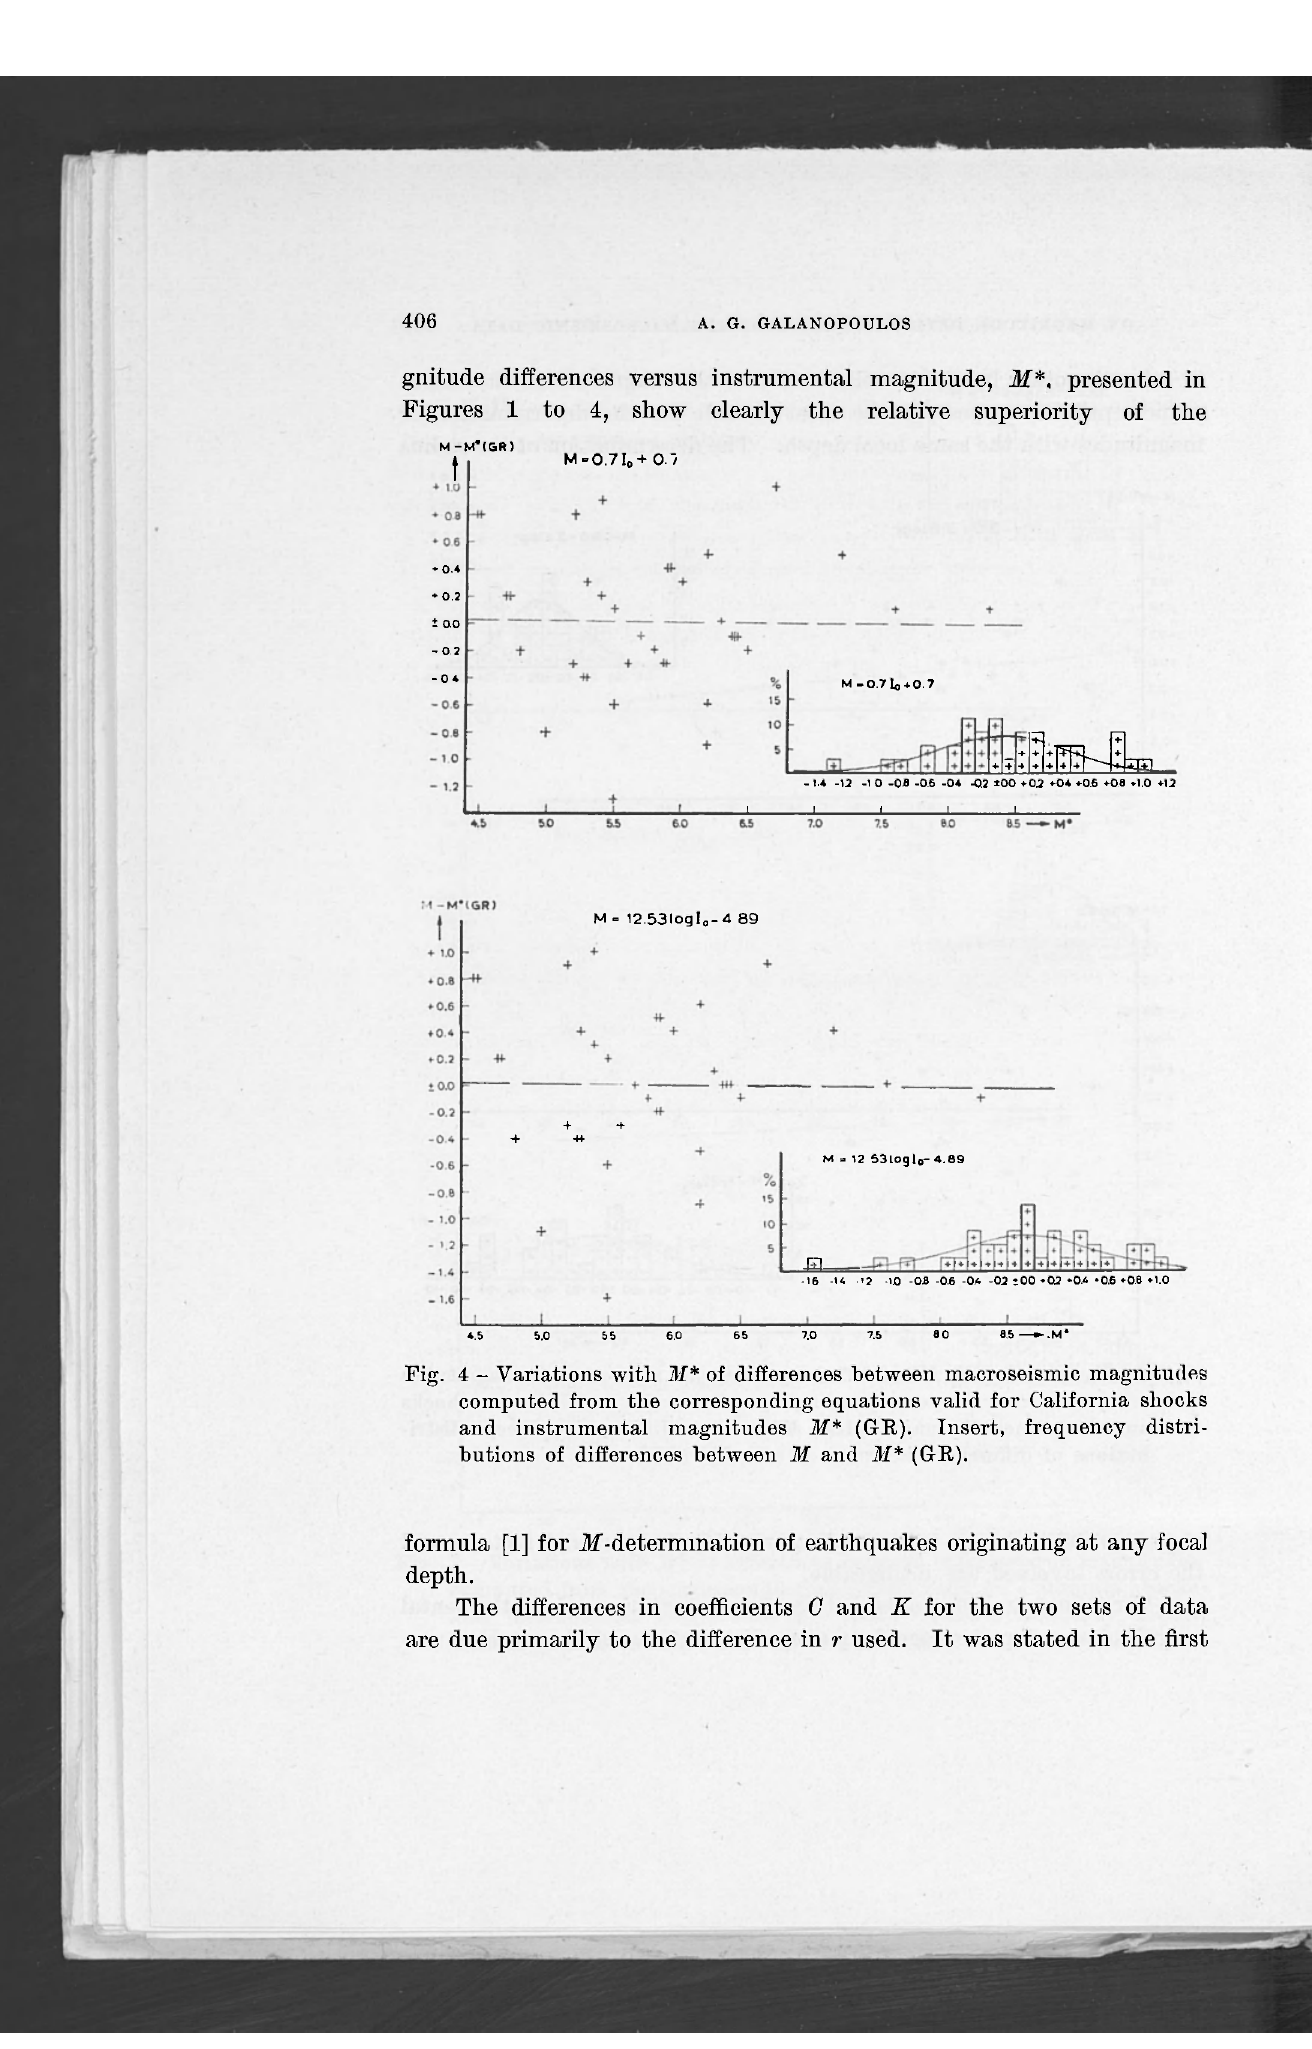
Fig. 4 - Variations with M* of differences between maoroseismic magnitudes computed from the corresponding equations valid for California shocks and instrumentai magnitudes M* (GR). Insert, frequency distri- butions of differences between M and M* (GR).